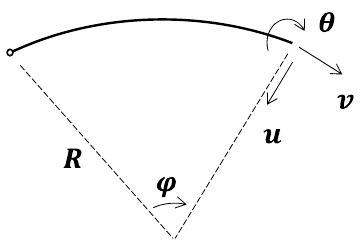
Figure 1. The direction of displacement.